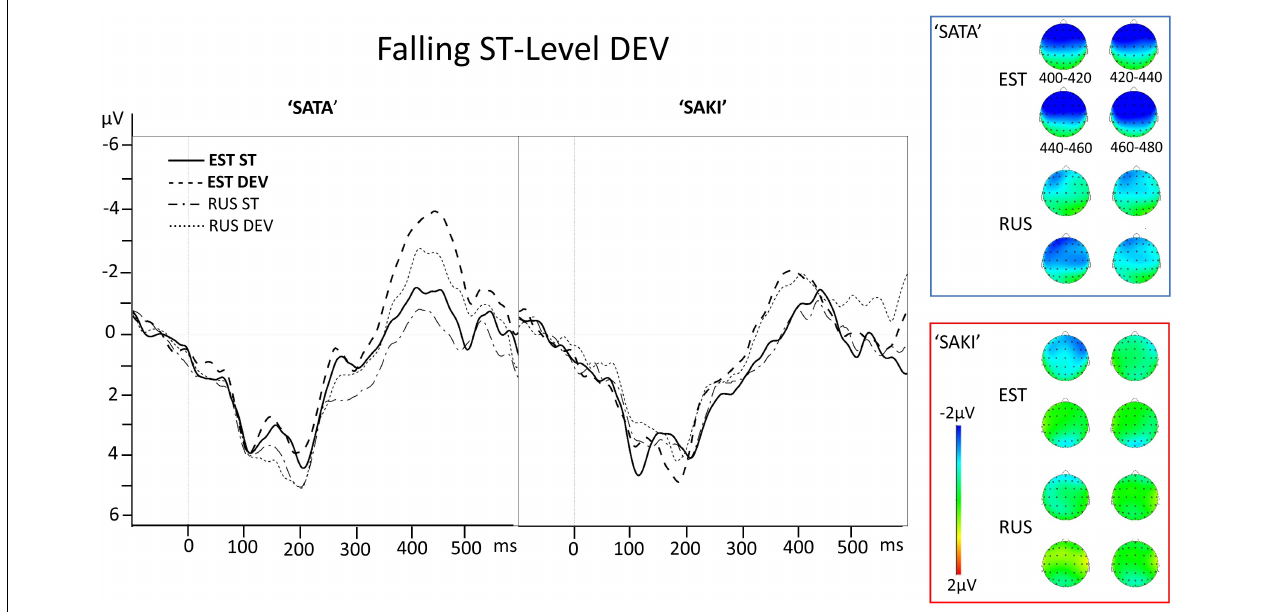
FIGURE 5 | Electrode AF3 averaged ERP activity for standard (ST) and deviant (DEV) stimuli in ‘Falling ST-Level DEV’ comparisons for ‘SATA’ and ‘SAKI’ stimuli in Estonian (EST) and Russian (RUS) Language groups. Right panel represents distribution of averaged mismatch response (DEV-ST) in 400–480 ms. Please observe, that first 83–100 ms are exactly the same for ST and DEV under comparison (consonant, see stimuli in Figure 1 ).